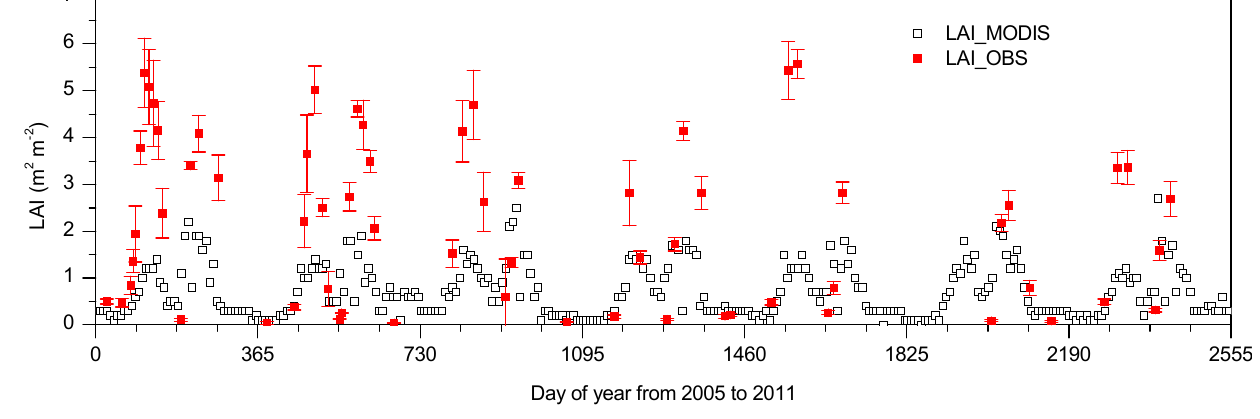
Figure 4. Comparison of MODIS and observed leaf area index (LAI) at the Yucheng (YC) cropland site.